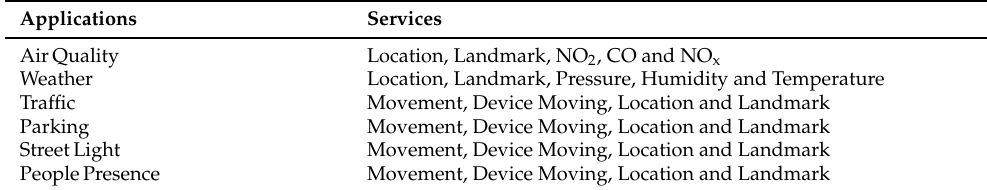
Table 7. Services and corresponding